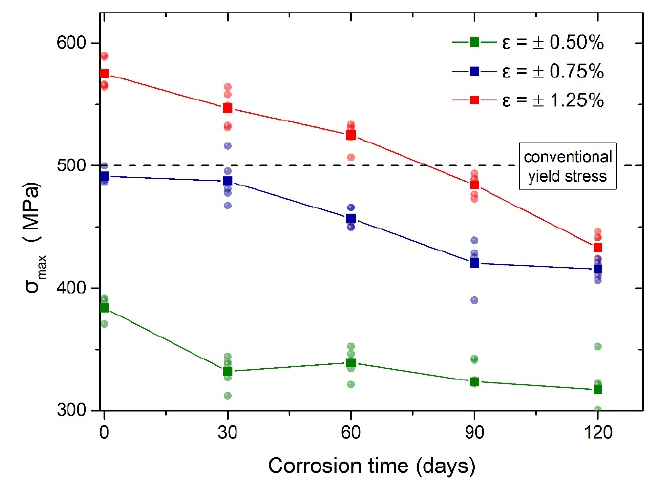
Figure 8. Relation between maximum stress and corrosion ratio for all cases of imposed defor- mation.